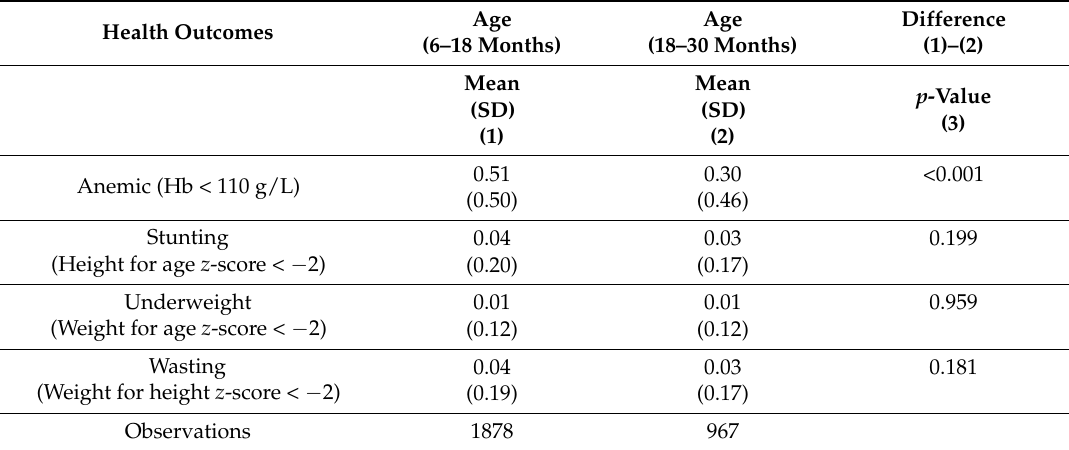
Table 4. Health outcomes of infants at different age